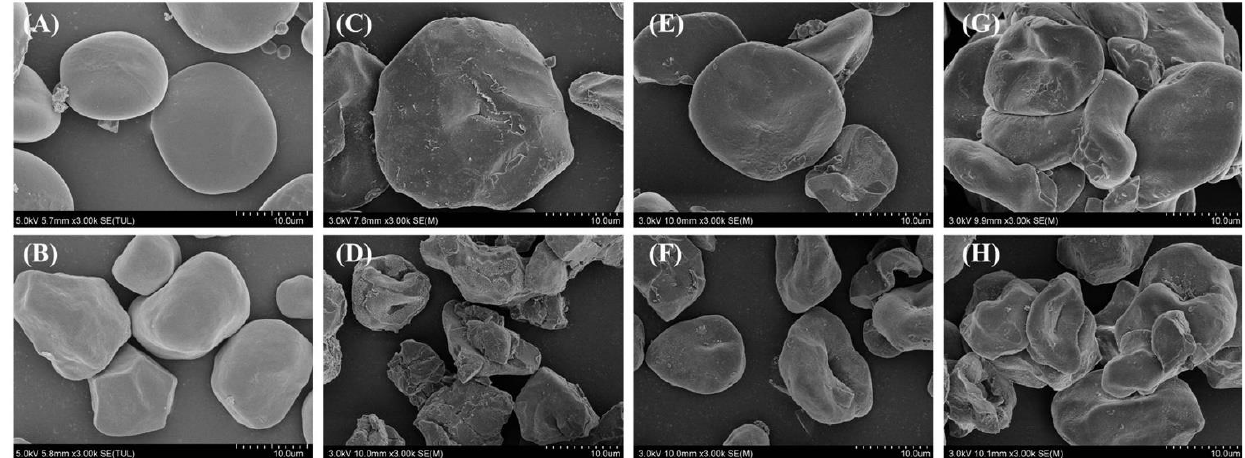
Figure 2. Scanning electron micrographs of starch and polyphenols-starch complexes. ( A ) Highland barley starch (HBS); ( B ) Amylose; ( C ) Gelatinized highland barley starch (HBS); ( D ) Gelatinized amylose; ( E ) 80% methanol extracted highland barley polyphenols-highland barley starch (MHBP-HBS) complexes; ( F ) 80% methanol extracted highland barley polyphenols (MHBP)-amylose complexes; ( G ) 80% acetone extracted highland barley polyphenols-amylose complexes (AHBP-HBS) complexes; ( H ) 80% acetone extracted highland barley polyphenols (AHBP)-amylose complexes.